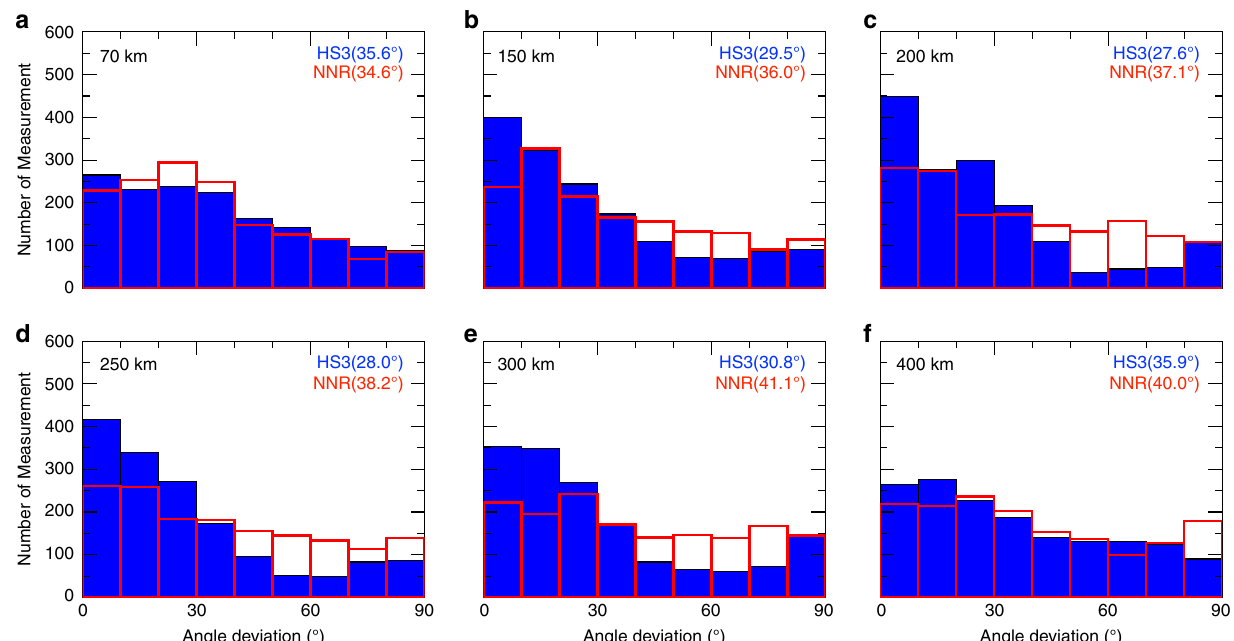
Fig. 9 The histograms of angle differences between the fast axis orientations in model US 32 and the plate motion model NUVEL-1A 58 . a – f Results at depths ranging from 70 to 400 km. Blue and red histograms are results for the hotspot and no-net rotation reference frames, respectively. Numbers in the brackets to the right corner of each histogram denote mean angle differences between these